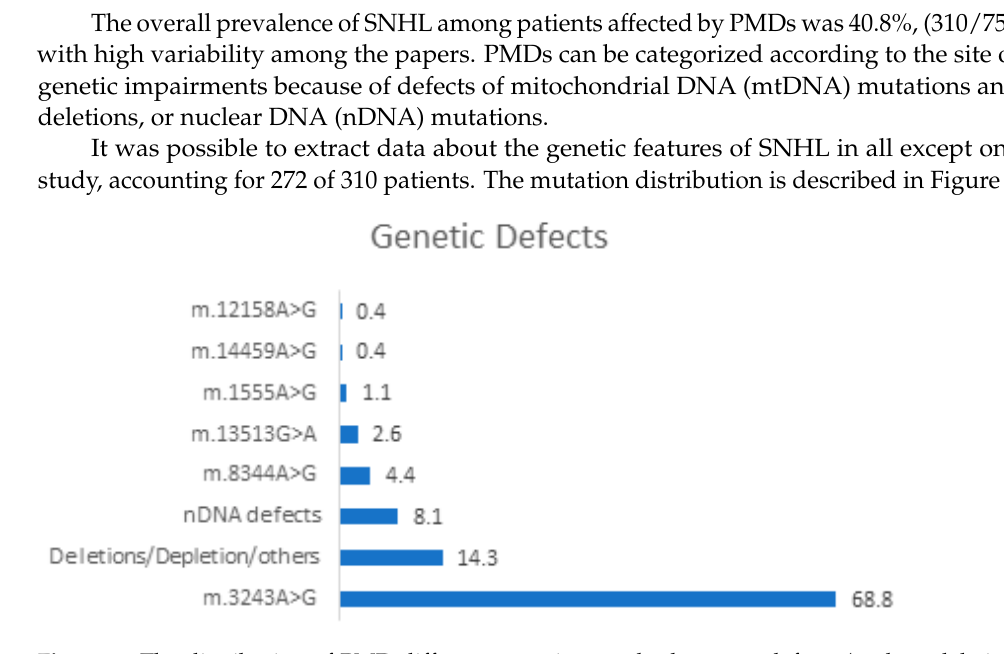
Figure 2. The distribution of PMD different mutations and other gene defects (such as deletion, depletion, and overexpression). All numbers in the figure are expressed as